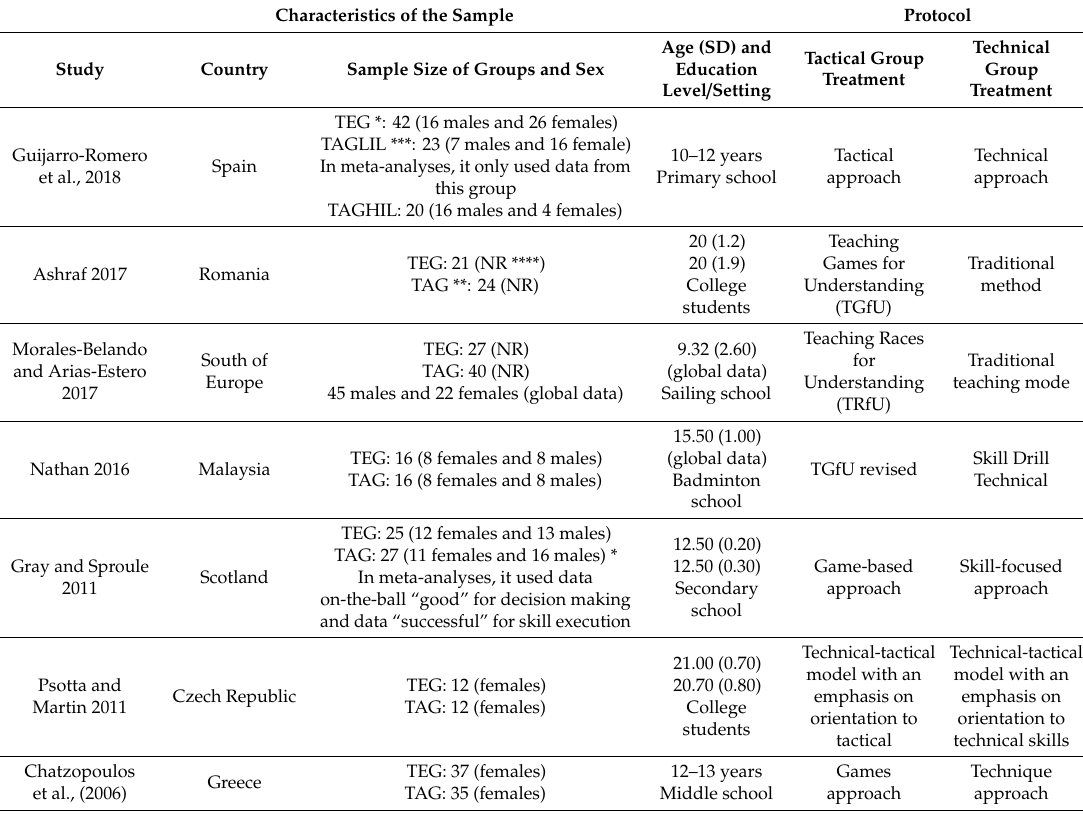
Table 2. Characteristics of the participants and the